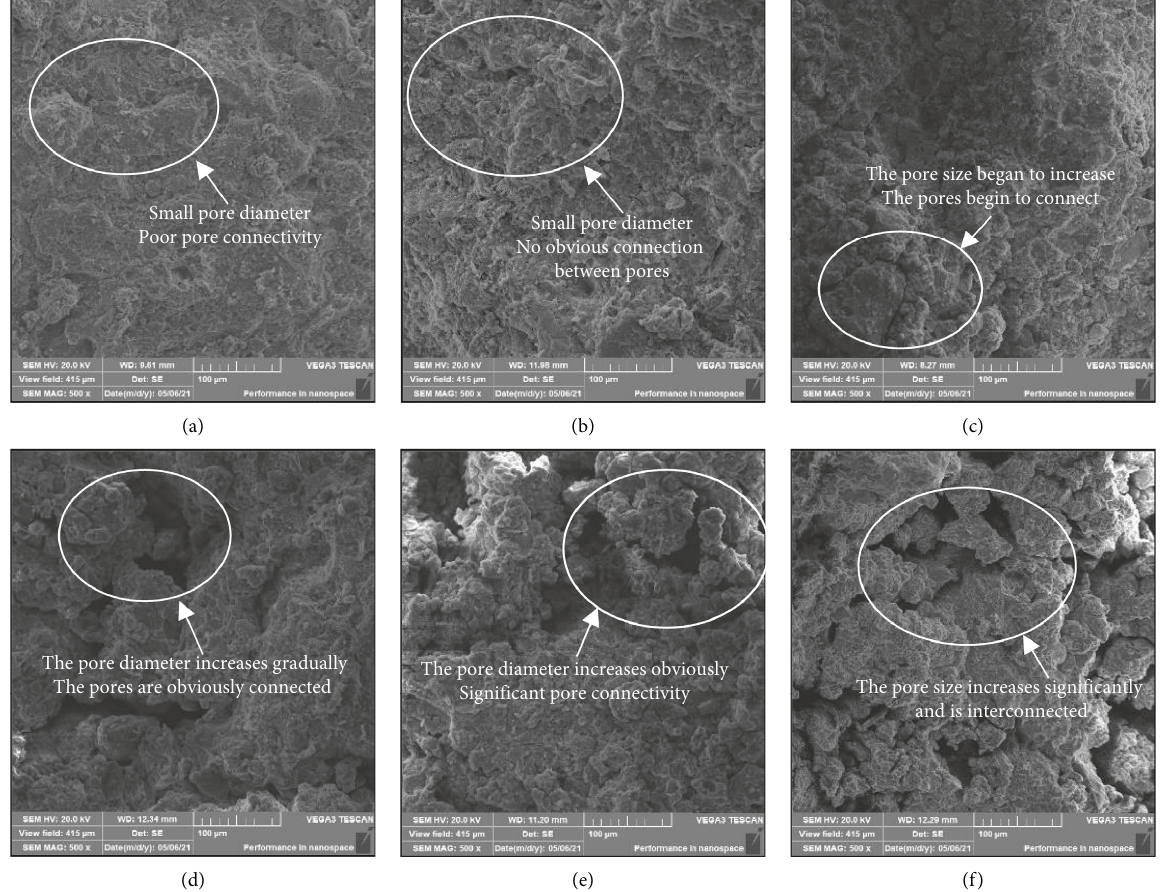
Figure 9: Microstructure images of samples with different amounts of HA reagent ( × 500). (a) 0% HA reagent, (b) 5% HA reagent, (c) 10% HA reagent, (d) 15% HA reagent, (e) 20% HA reagent, and (f) 25% HA